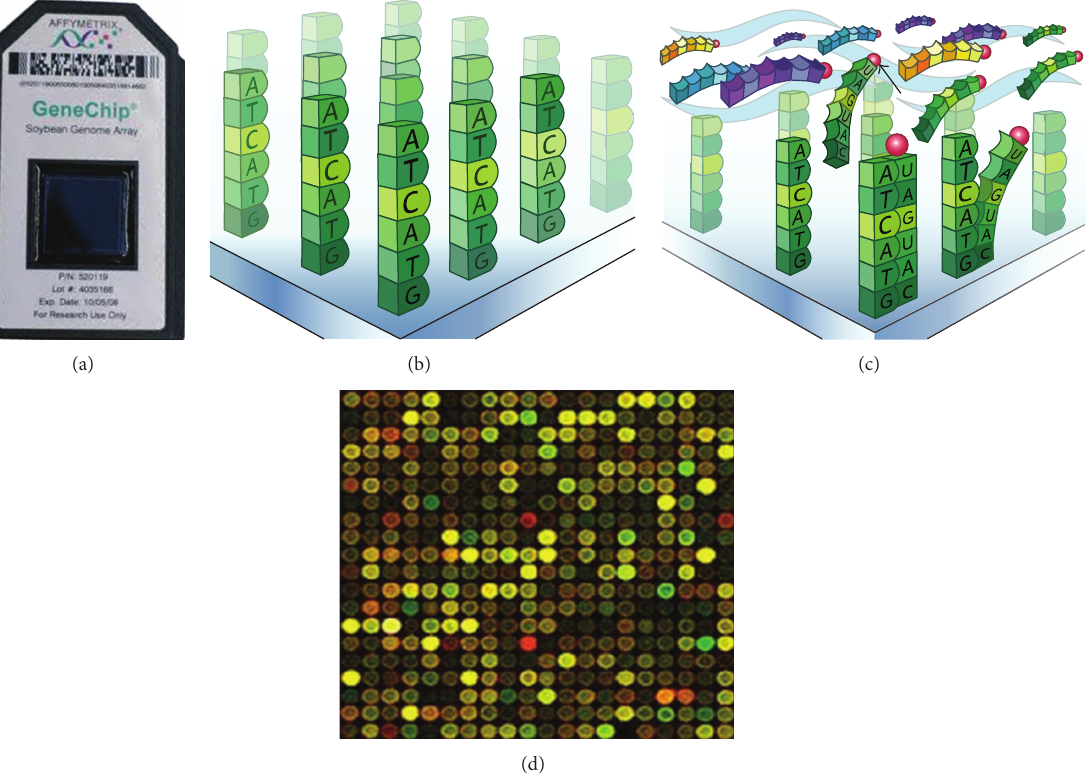
Figure 2: (a) Microarray chip. (b) Oligonucleotides on a solid base. (c) Hybridization between fluorescently labeled target sequences and probe sequences. (d) A digital